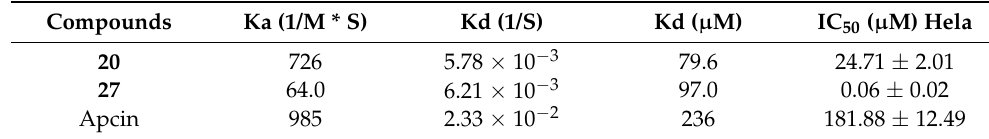
Figure 1. ( A ) Expression levels of Cdc20 protein in different cell lines. ( B ) Cdc20 levels were measured by Western blot 12 h after the addition of compounds. The reproducibility of the results was confirmed by at least two separate experiments. ( a ) Quantitative results of ( A ) compared to Hela. ( b ) Quantitative results of ( B ) compared to control. Statistical significance was calculated by two-tailed unpaired t test (* P < 0.05, ** P < 0.01, *** P < 0.001, ****P < 0.0001). Table 4. Comparison of kinetics and affinity parameters of compound binding to recombinant human Cdc20 *.